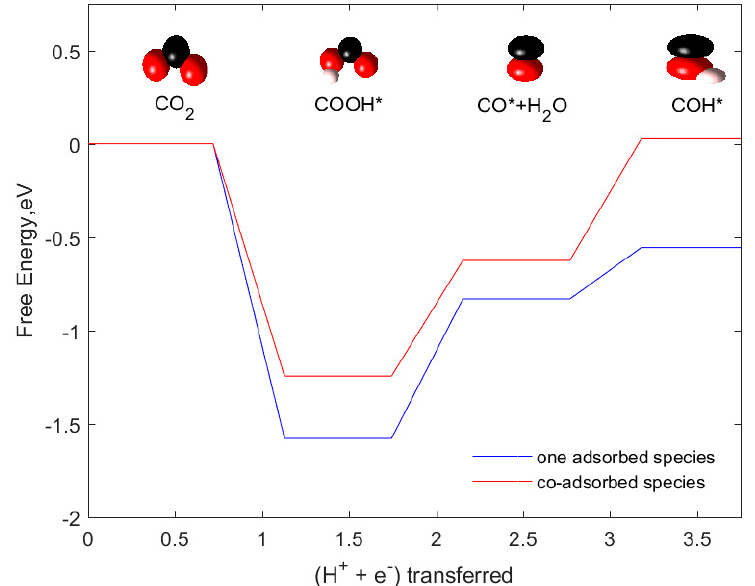
Figure 8. Role of surface coverage on reaction energetics. Blue: one adsorbed species per WC/graphene catalyst system. Red: Co-adsorbed species per WC/graphene catalyst system. Color code of atoms: red: oxygen, black: carbon, white: hydrogen.